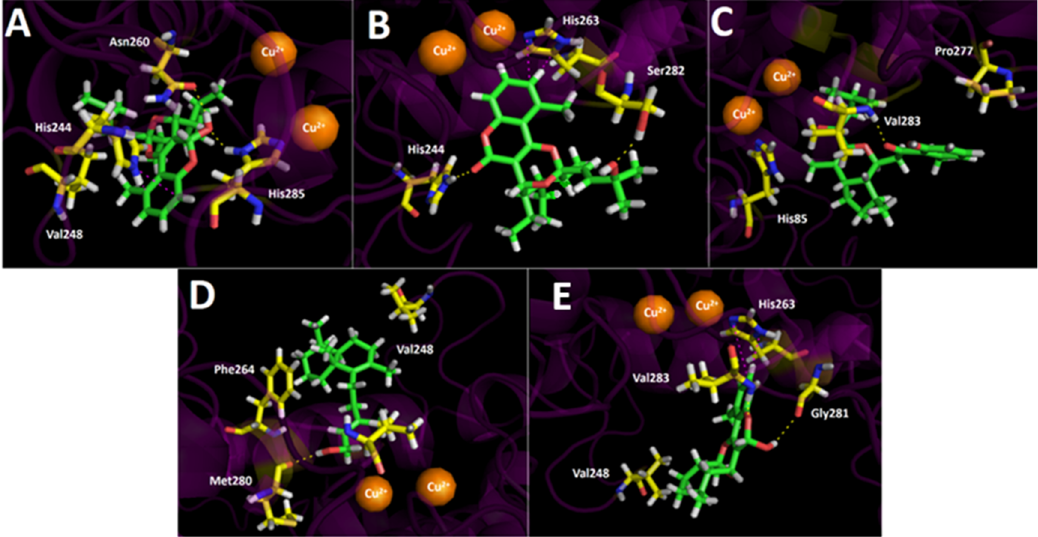
Figure 8. Predicted binding mode and predicted intermolecular interactions of selected major metabolites from the Gypothamnium pinifolium n -hexane and ethyl acetate extracts and the residues of Agaricus bisporus mushroom tyrosinase catalytic site yellow dotted lines indicate hydrogen bond interactions and magenta dotted lines represent T-shaped interactions. ( A ) Cyclolycoserone in the catalytic site; ( B ) 8-epi-gypothaminol in the catalytic site; ( C ) 2- nor -1,2-secolycoserone in the catalytic site; ( D ) Ent -labda-8,13- E -diene-15-ol in the catalytic site; ( E ) 6-hydroxyaphyllodenticulide in the catalytic site.